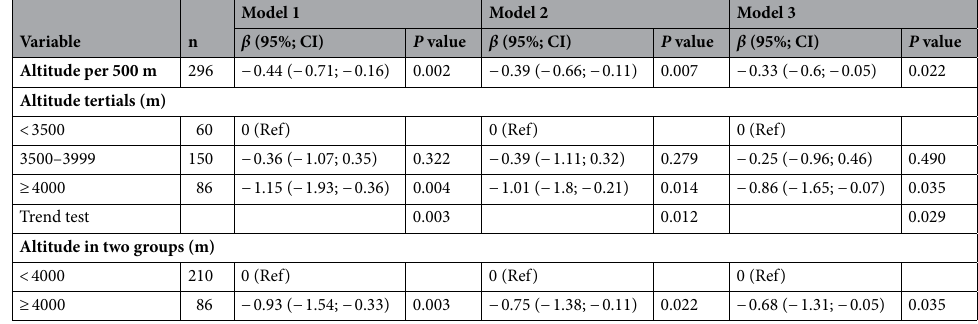
Table 2. Multivariable linear regression analyses of altitude associated with serum folate level. Model 1: non- adjusted. Model 2: adjusted for age and sex. Model 3: adjusted for age, sex, HGB, RBC, HCT, and HDL-C. CI confidence interval, Ref